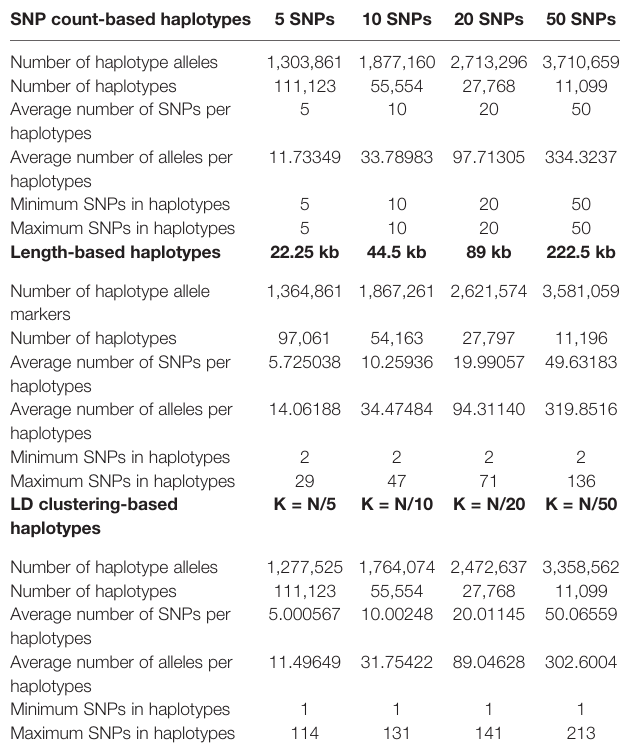
TABLE 2 | Haplotype and allele statistics of each haplotype de fi ning method at different sizes. SNP count-based haplotypes 5